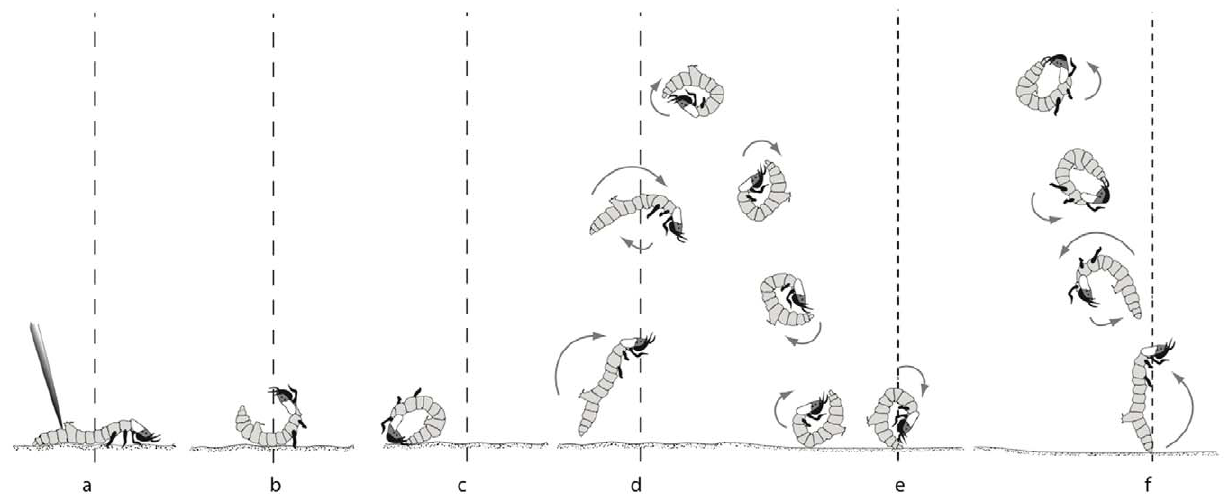
Figure 1. A generalized leaping and wheel initiation sequence in C.dorsalismedia larvae. The number, height, and direction of individual components vary markedly depending on wind speed and fine-scale surface topography. The two dotted lines (coarse and fine) calibrate the successive illustrations in two locations as the larva moves along the beach. Sequence of events: a) being prodded; b–c) coiling and rolling backwards until pygopod (tail) contacts sand; d) straightening out, pushing off sand into the air, rotating forward; e) landing on sand; at this point larva either begins wheeling, returns to extended position (a), or proceeds to f) when pygopod or head contacts sand, straightening out, pushing off sand into the air, rotating backward; when larva lands on sand, proceeds to either (a) or